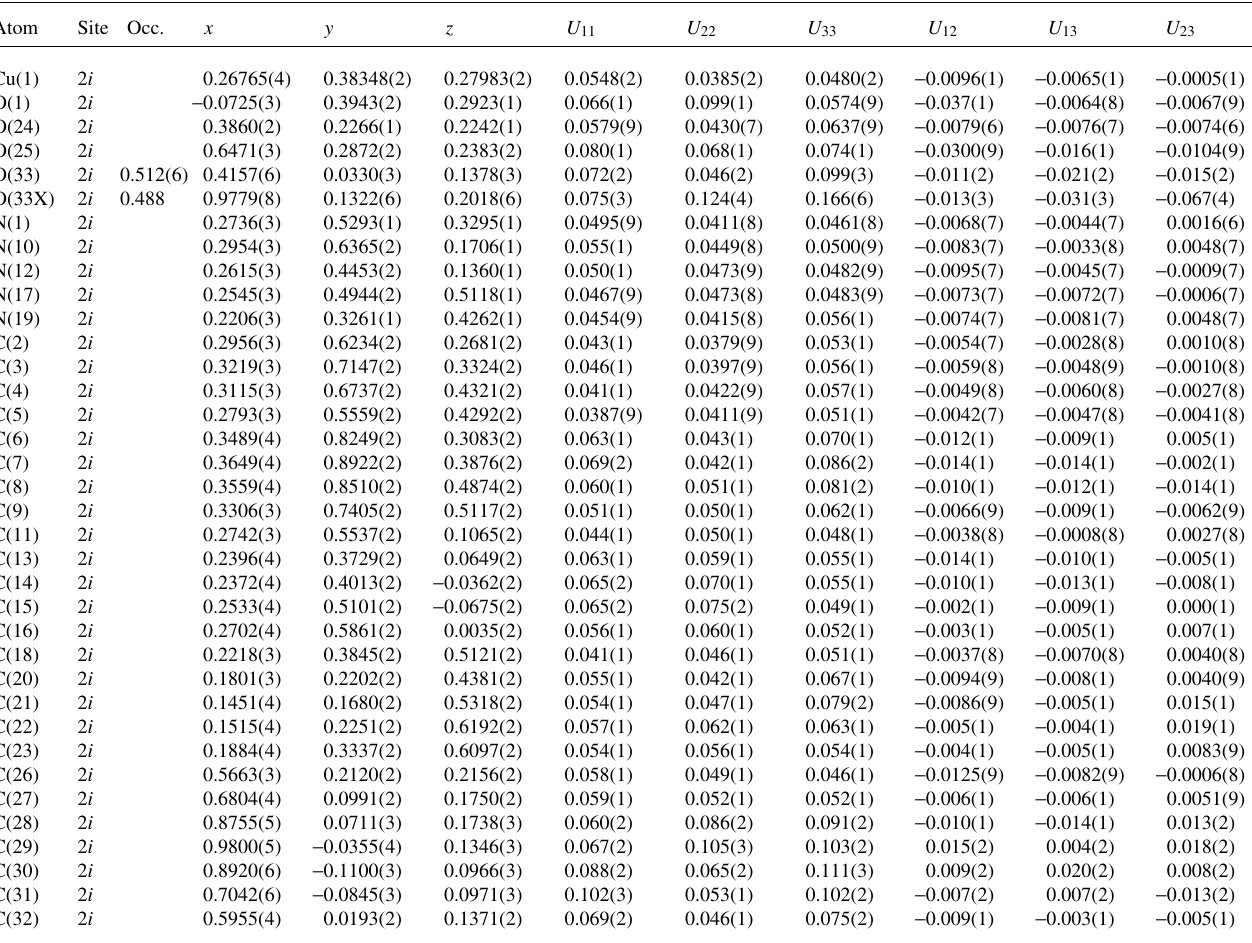
Table 3. Atomic coordinates and displacement parameters (in Å 2 ) .